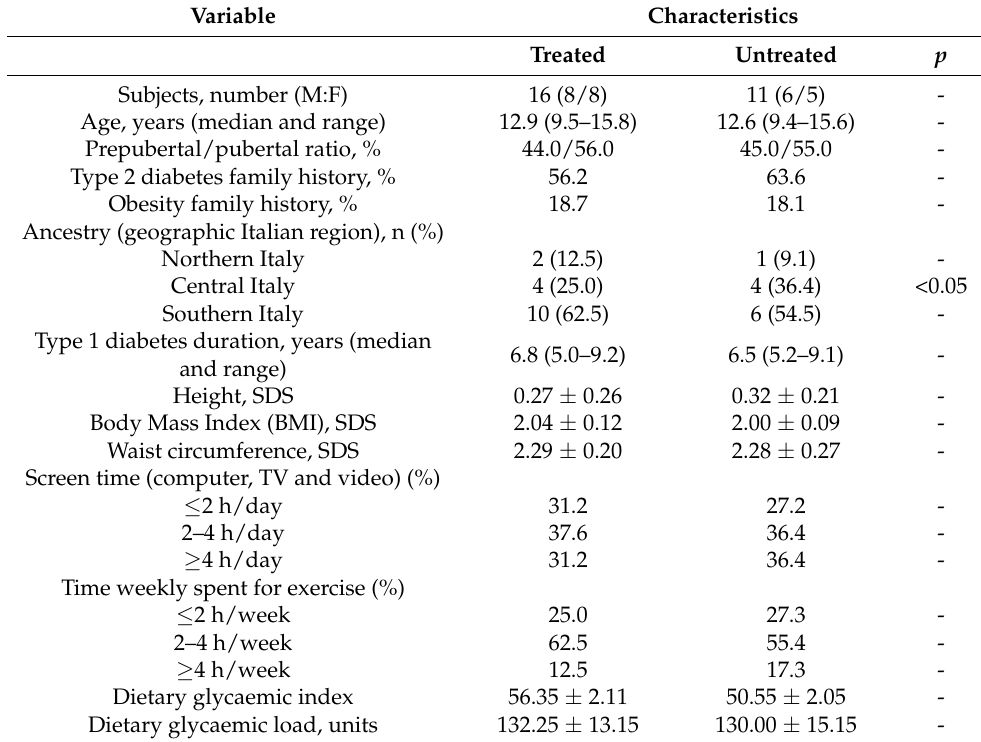
Table 1. Baseline demographic and clinical characteristics in Policaptil Gel Retard ® (PGR)-treated and untreated children with type 1